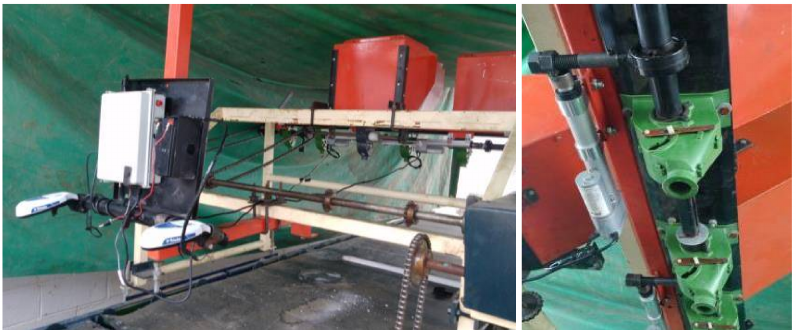
Figure 3. Setup of the test bench with two N-sensors up front connected through the control box with the VRA fertilizer meters ( left ); close-up view of the fluted rollers connected with the electric actuator piston ( right ).